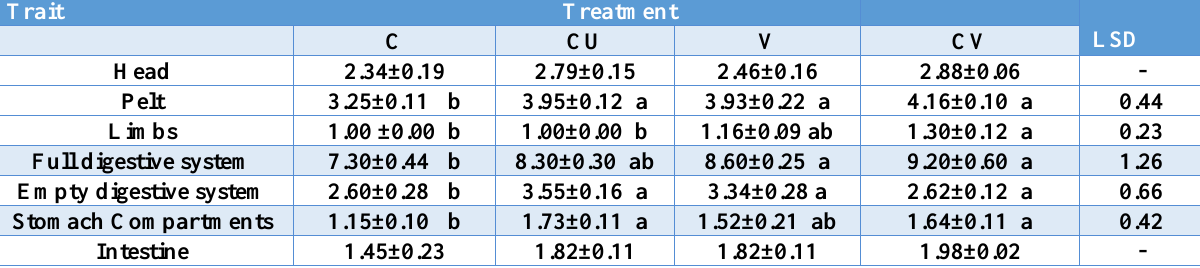
Different letters showed significant difference among treatments at 5%